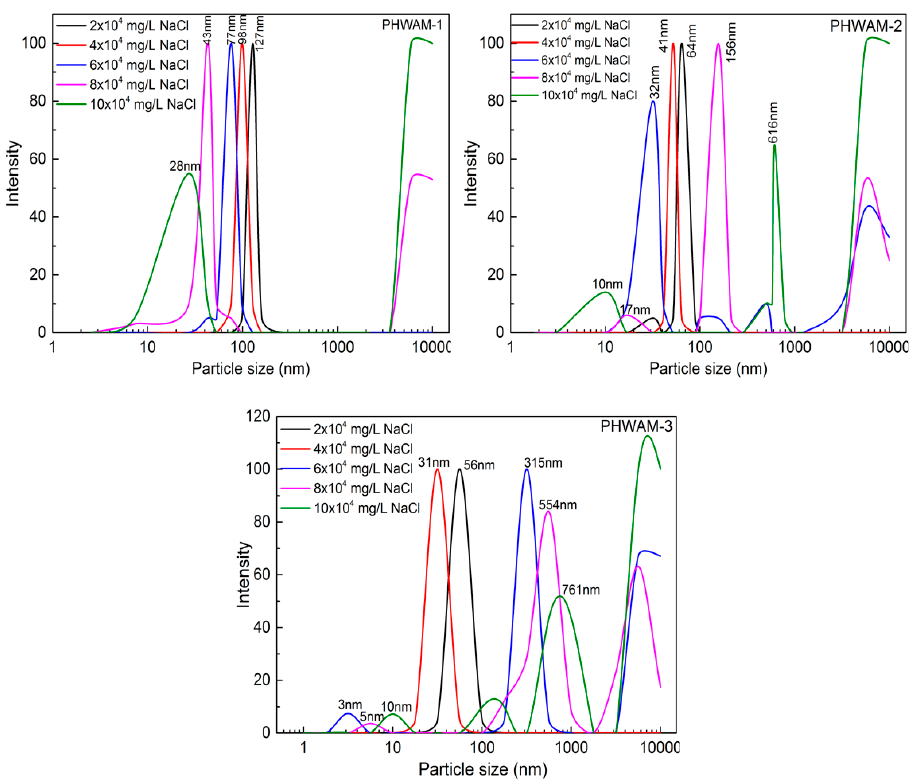
Figure 9. Effect of salt on the particle size distribution of the polymers.